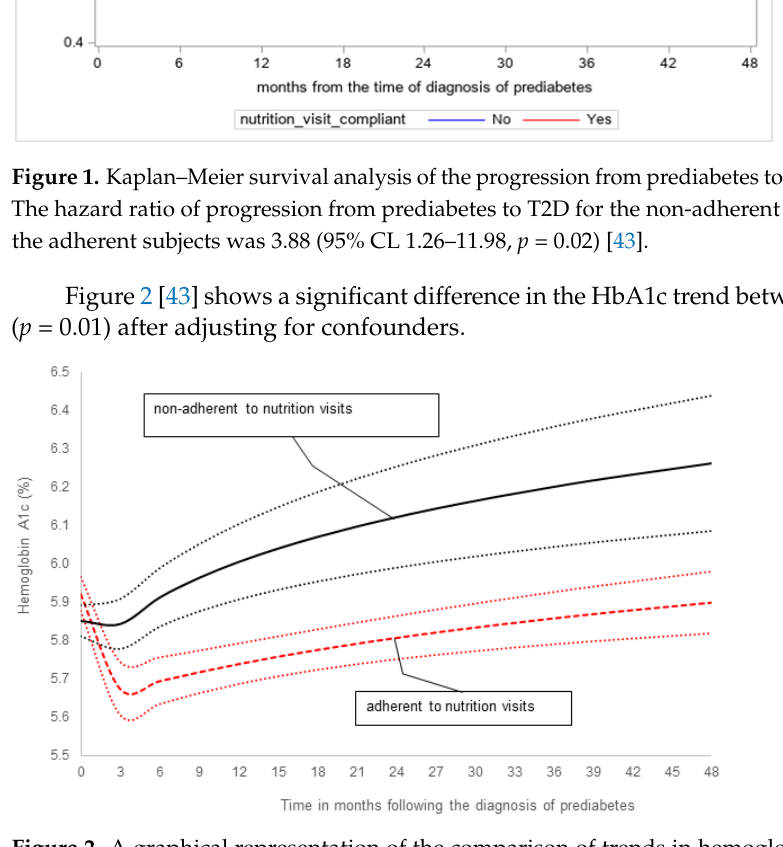
Figure 2. A graphical representation of the comparison of trends in hemoglobin A1c between the adherent and non-adherent subjects. This shows that the difference in HbA1c trends between the two groups remained significant after adjusting for age, sex, race/ethnicity, metformin use, and BMI z-scores ( p = 0.01) [43].